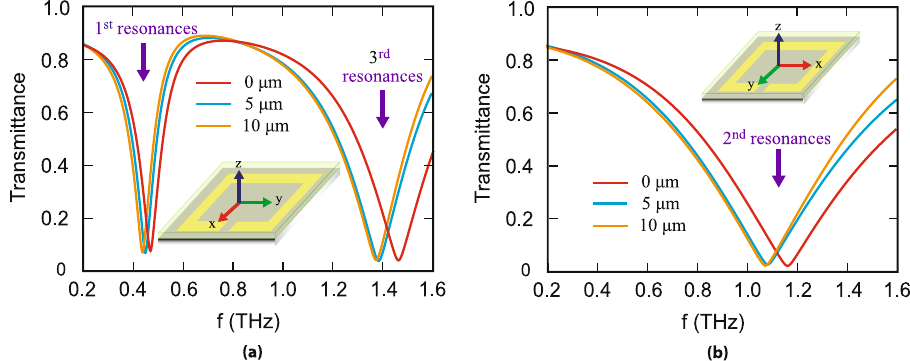
Figure 2. Numerically calculated THz transmittance through the metamolecule with and without the analyte as described in this work. ( a ) Shows transmittance for polarization parallel to split gap which yields two resonances 1 st and 3 rd order; ( b ) Depicts the same for polarization perpendicular to the gap, which yields 2 nd order resonance.